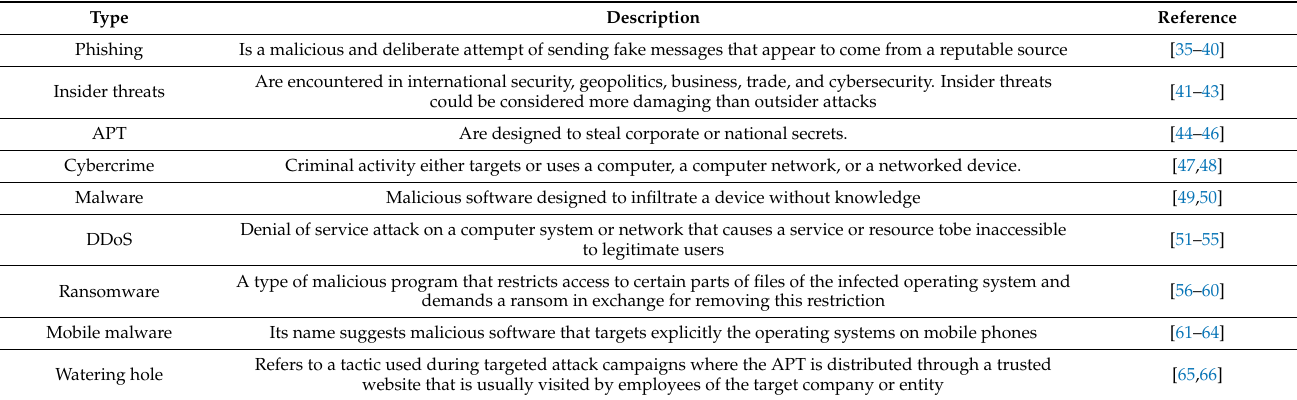
Table 3. Cybersecurity attacks detected in text mining